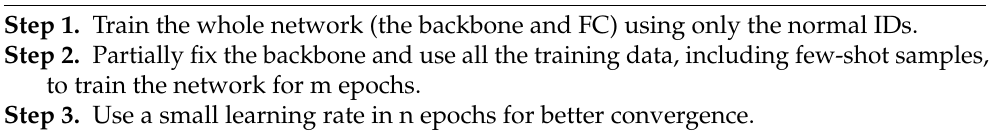
Algorithm 1 Progressive Training